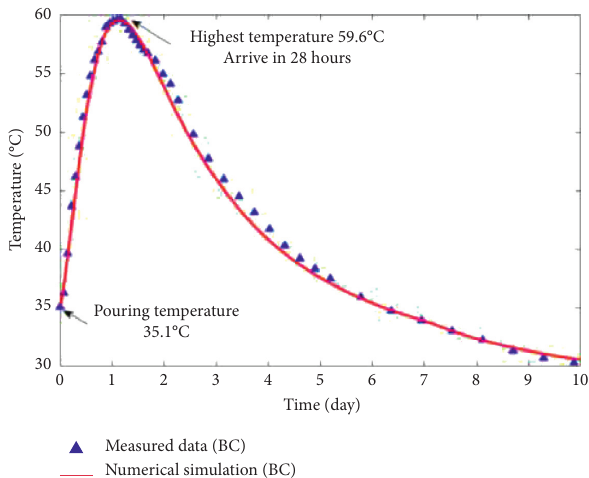
Figure 22: Comparison of measured and simulated temperature duration curves of reference concrete (BC).